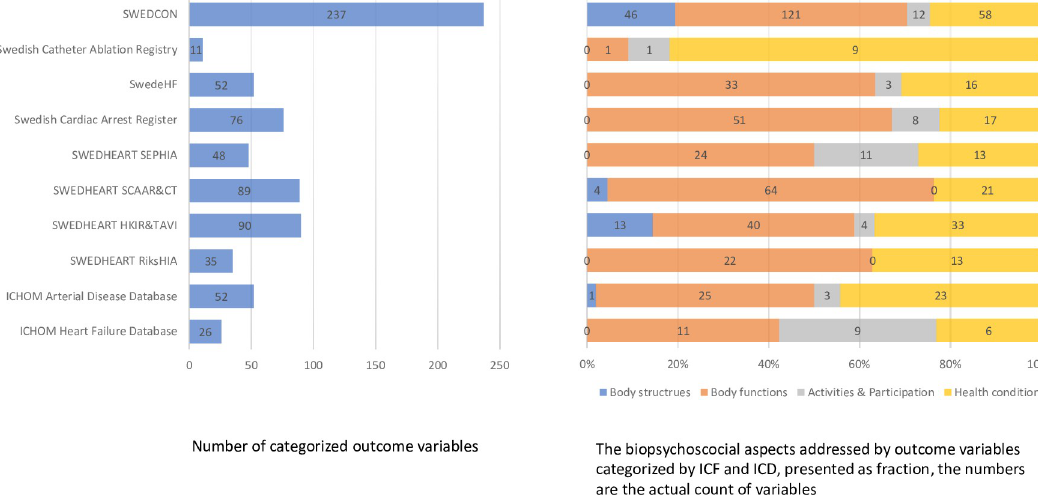
Fig 2. Overview of the total numbers of outcome variables and the distribution (proportion in percentage) of the type of variables according to ICF components and health condition. Body functions = physiological and mental functions of body systems; Body structures = organs, limbs and other anatomical parts; Activities & Participation = ability and actual execution of a task by a person; Health condition = Disease, disorder or injury as defined by the International Classification of Diseases